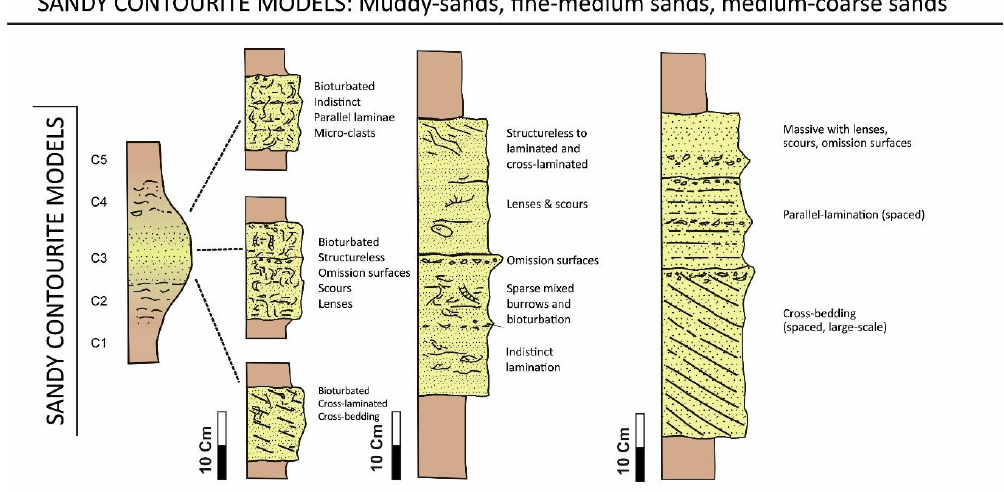
Figure 14. The sandy contourite family for muddy sands, fine-to-medium sands and medium-to-coarse sands. After [105].